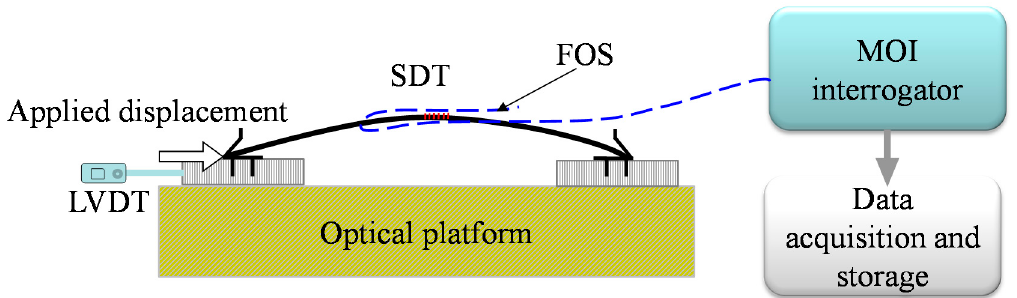
Figure 5. Setup of the calibration test.